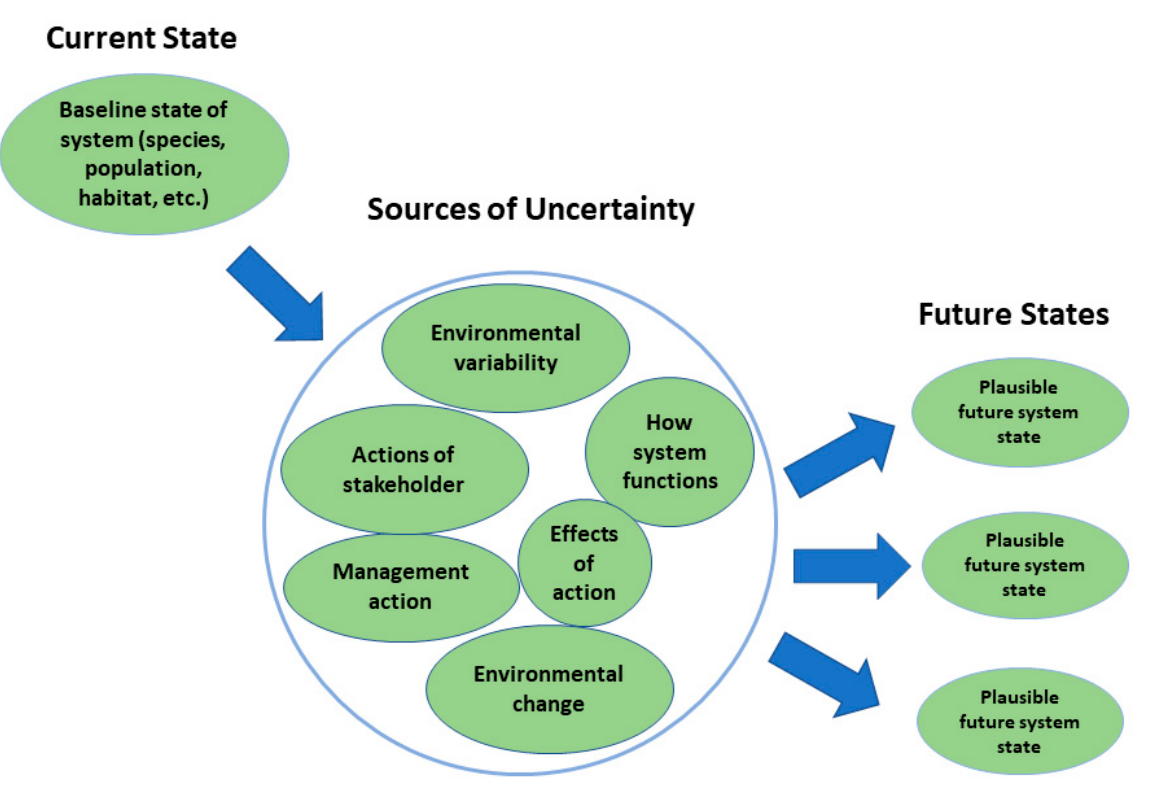
Figure 1. Conceptual diagram illustrating some of the ways uncertainty can come into projections of future system states for ecological systems. There may be initial uncertainty about the current state of a system for many wildlife managers, which may be further complicated by additional uncertainty about management or societal actions and interacting processes, as well as uncertainty about the context and function of multiple plausible future states.